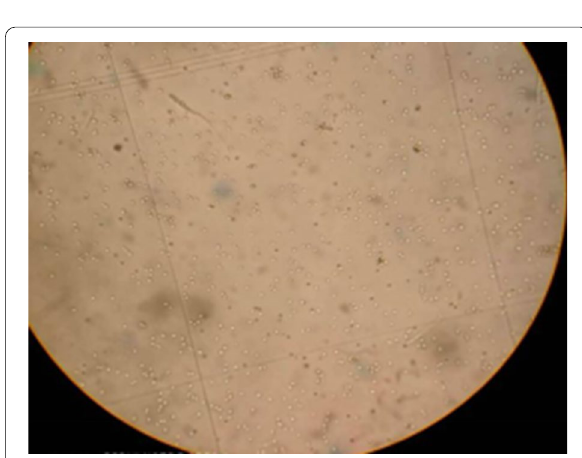
Fig. 4 Conidial density of Isaria fumosorosea (MH414514.1) under neubauer hemocytometer (40